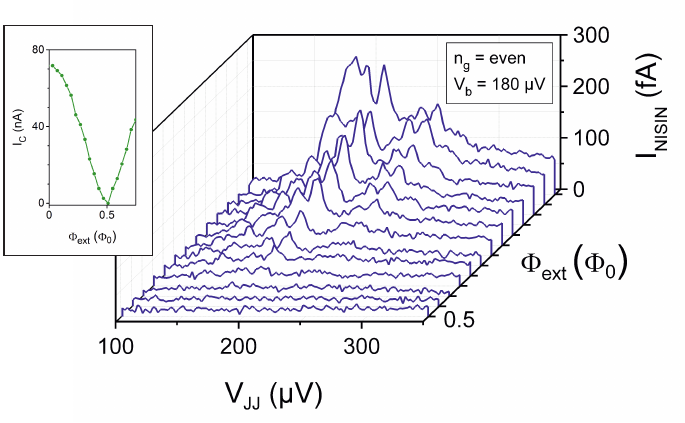
Figure 7. The detector response to the increase in the magnetic flux from 0 up to the value Φ 0 /2. The gradual decay of the response is a result of decreasing the source critical current (see inset) and, therefore, the radiation power to a vanishing value.